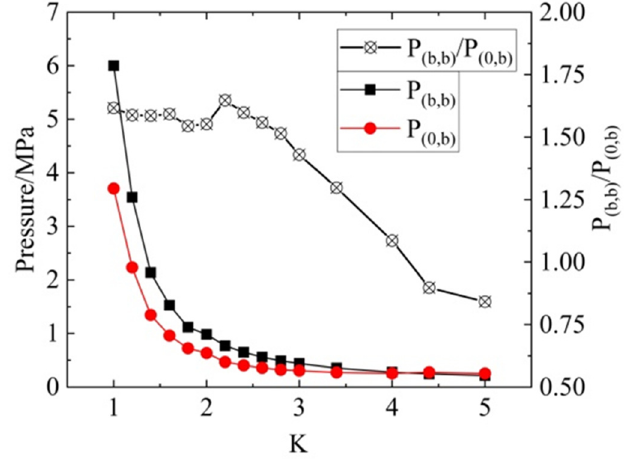
Figure 11. Changes in the pressure and pressure ratio at two lateral points with K when b = 500 mm and W = 100 g.